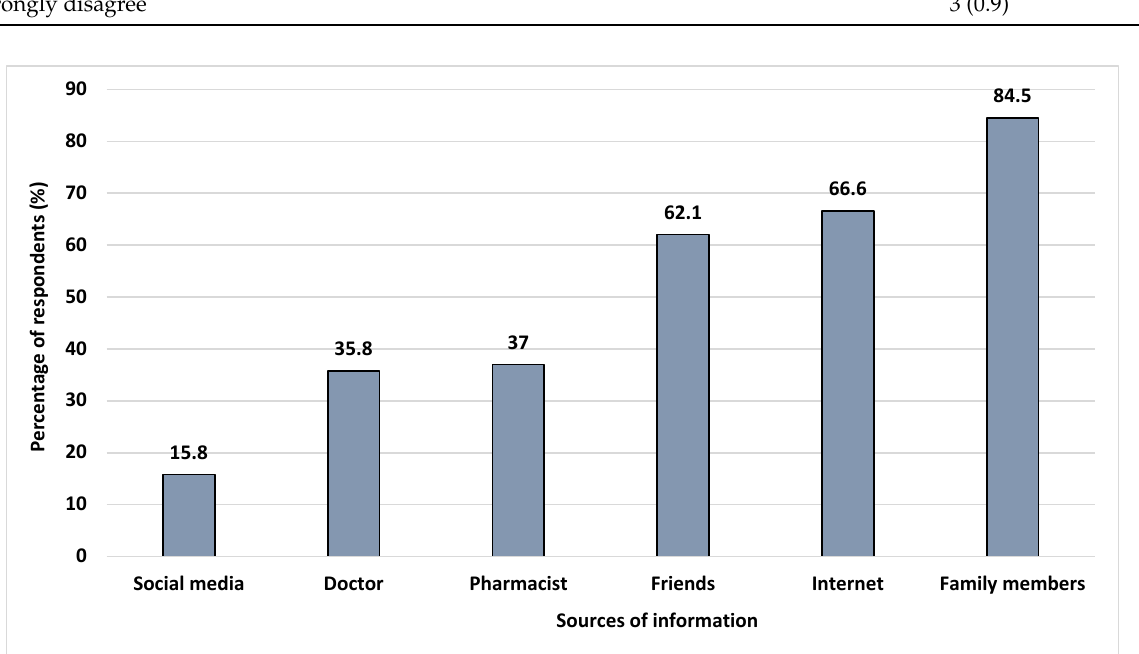
Figure 1. Sources of information considered by the respondents before purchasing an OTC medi- cine.